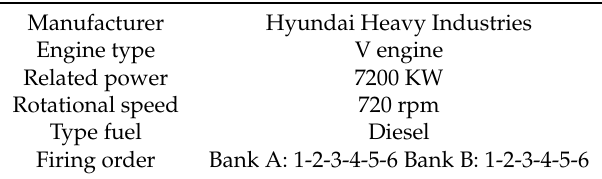
Table 1. Test Engine